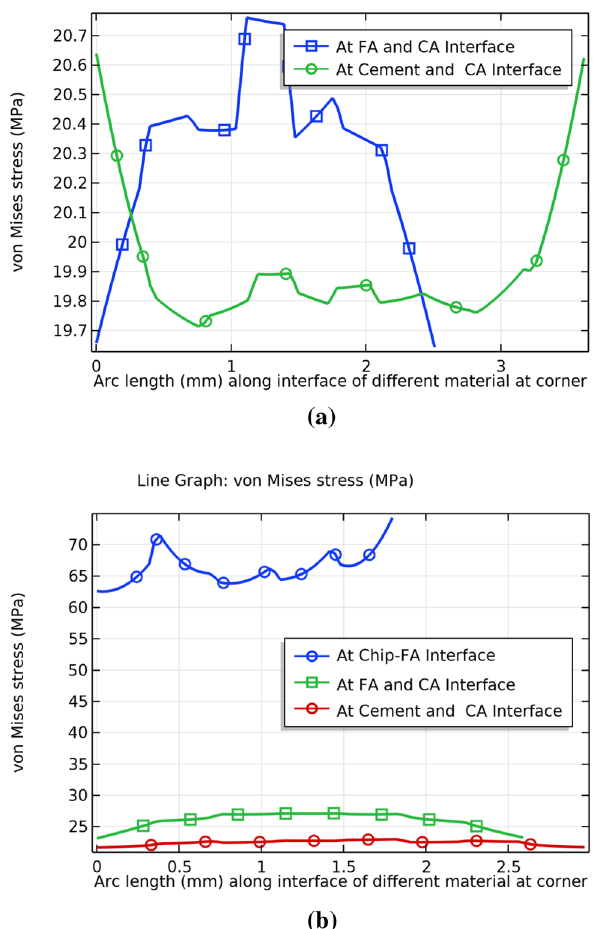
Figure 12. Von Mises stress at the interfaces of ( a ) Concrete ( b ) Green CBC representative